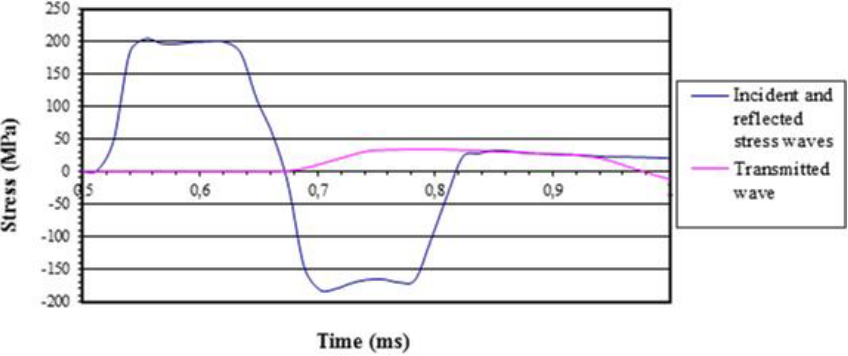
Figure 8. Incident and reflected stress waves pertinent to the modified SHTB (Model 2) when using SiC-reinforced ZC71 magnesium alloy at − 5000mms − 1 .